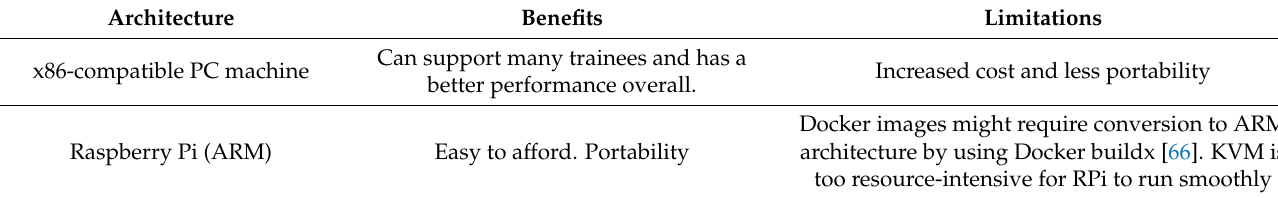
Table 4. Benefits and limitations of using a typical x86 compatible PC machine and Raspberry Pi.